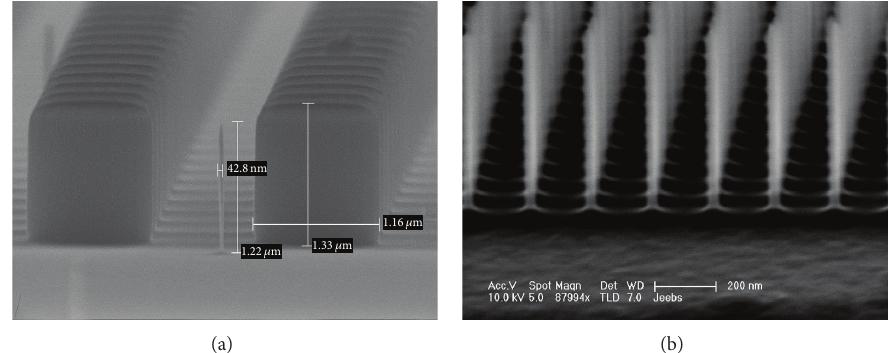
Figure 4: SEM image of plasma-etched nanopillars demonstrating size-independent etching (a) 1 𝜇 m pillar beside a 50 nm pillar and (b) 50 nm pillar array.